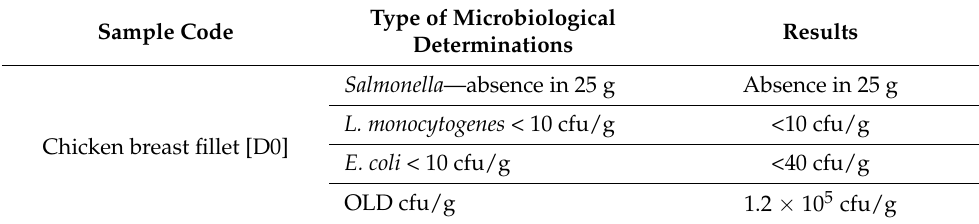
Table 10. Microbiological quality of fresh chicken breast.